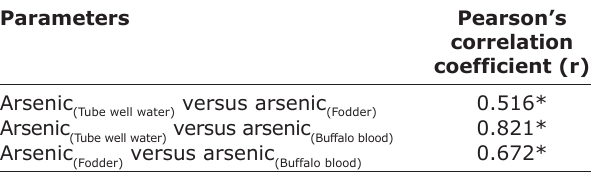
Table-2: Relationship between arsenic concentration in tube well water, fodder and untreated buffalo blood samples of arsenic contaminated area.